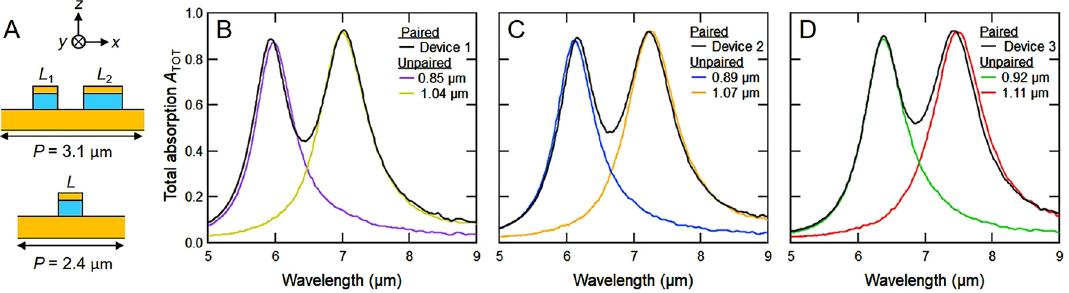
Figure5: Comparisonofpairedquantumwellinfraredphotodetector(QWIP)stripesfromdual-banddevices(black)andunpairedQWIPstripes with identical L (colored). A) One period of each structure shown schematically for comparison. B – D) Experimental total absorption ( A TOT ) taken from s -polarized re fl ection (Incidence angle θ = 26 ° in the y – z plane) of Devices 1, 2 and 3 along with corresponding unpaired QWIP stripes. L of the unpaired QWIP stripes corresponds with either L 1 or L 2 in the paired QWIP stripe. An unpaired QWIP stripe with L = 0.93 μ m is showntobecomparedwiththepairedQWIPstripewith L 1 =0.92 μ mduetolackofanunpairedQWIPstripeattheexactdimensions.All A TOT is calibrated, thus independent of the device area.